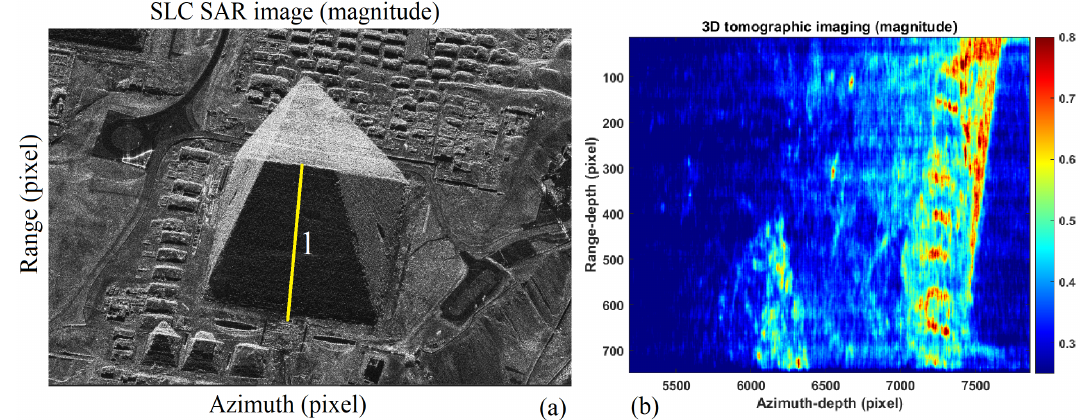
Figure 29. SAR images. ( a ): SLC SAR image (magnitude). The tomographic line 1 is oriented along the Eastern side of the pyramid. ( b ): Tomographic result (magnitude).